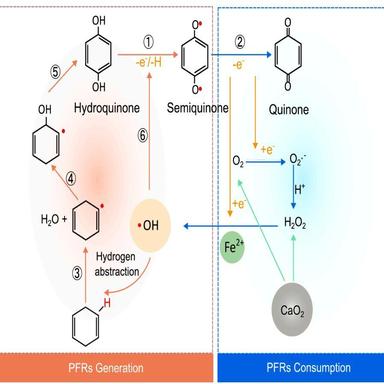
Transformation of PFRs on biochar in the sytetem: consumption and regeneration of PFRs during hydroxyl radicals production.